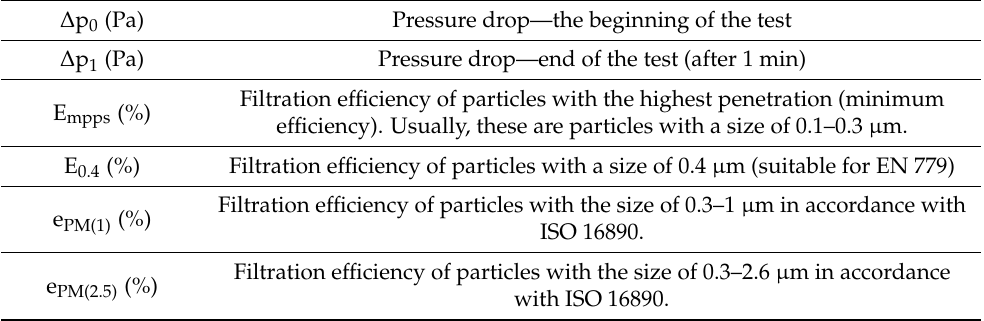
Table 4. Filtration efficiency characteristics.